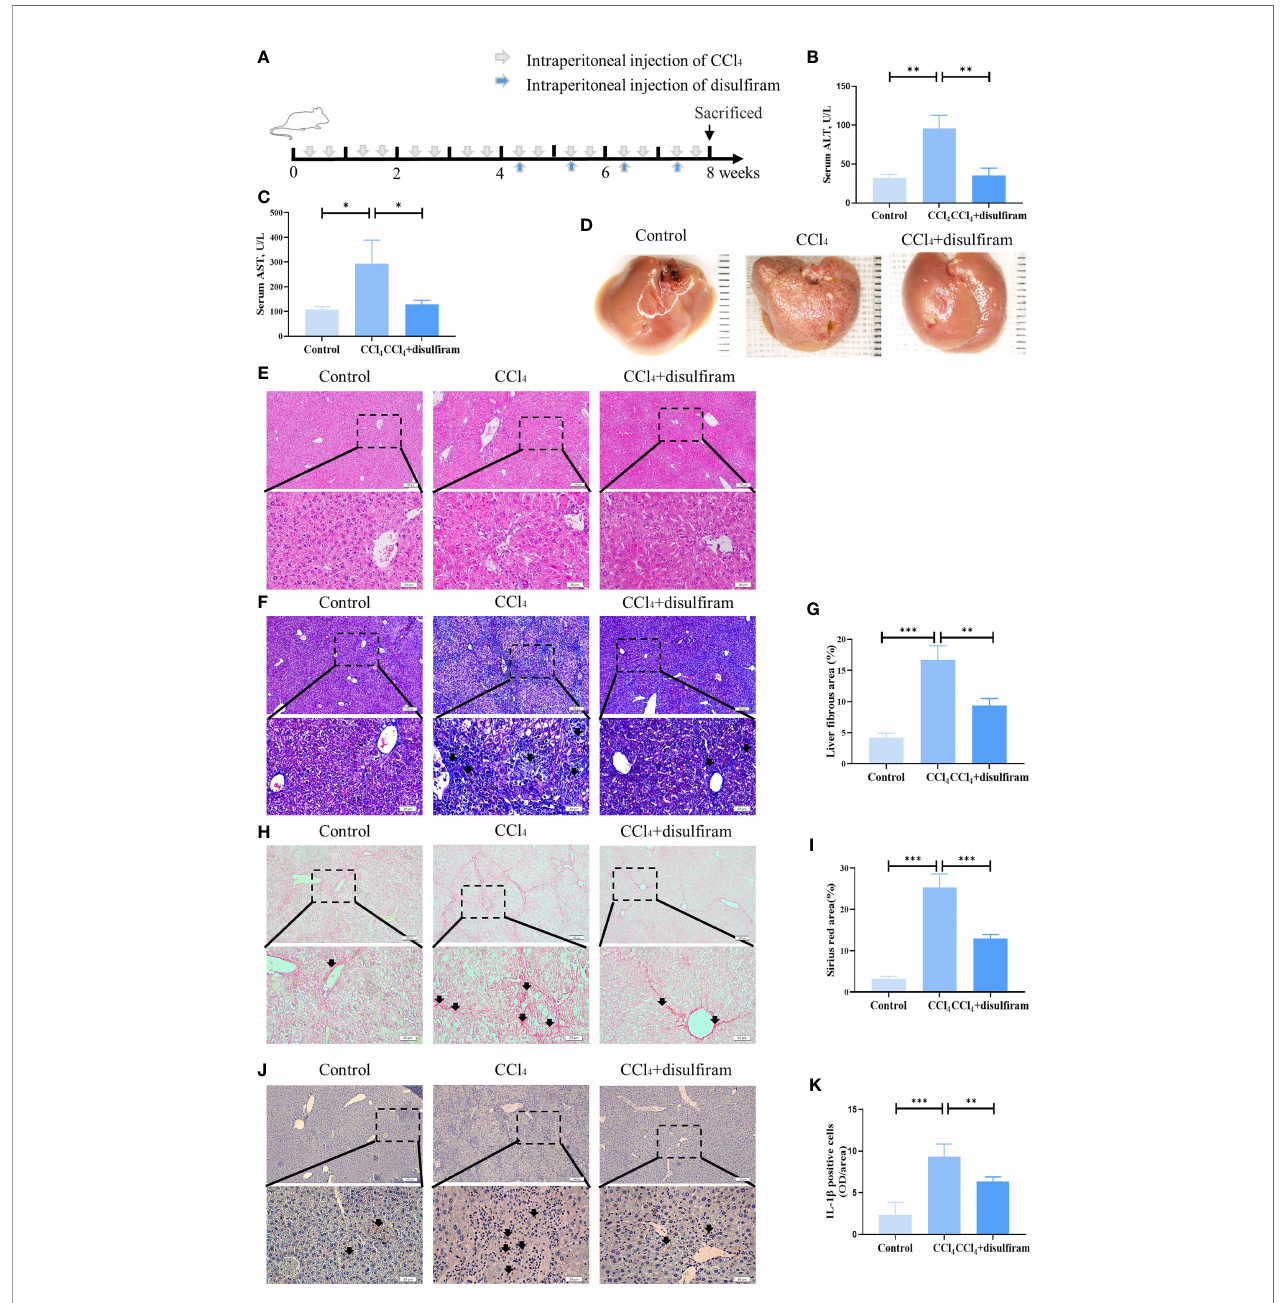
FIGURE 5 | Pyroptosis inhibitor disul fi ram attenuated CCl 4 -induced liver cirrhosis. (A) The schema of CCl 4 and disul fi ram injection to induce liver cirrhosis and treatment in mice. (B, C) The levels of serum ALT and AST from control, CCl 4 , and disul fi ram-injected mice. (D) The gross appearance of the liver tissues from control, CCl 4 , and disul fi ram-injected groups. (E, F) H&E staining of liver tissues from control, CCl 4 , and disul fi ram-injected groups. (F, G) The collagen deposition in livers from control,